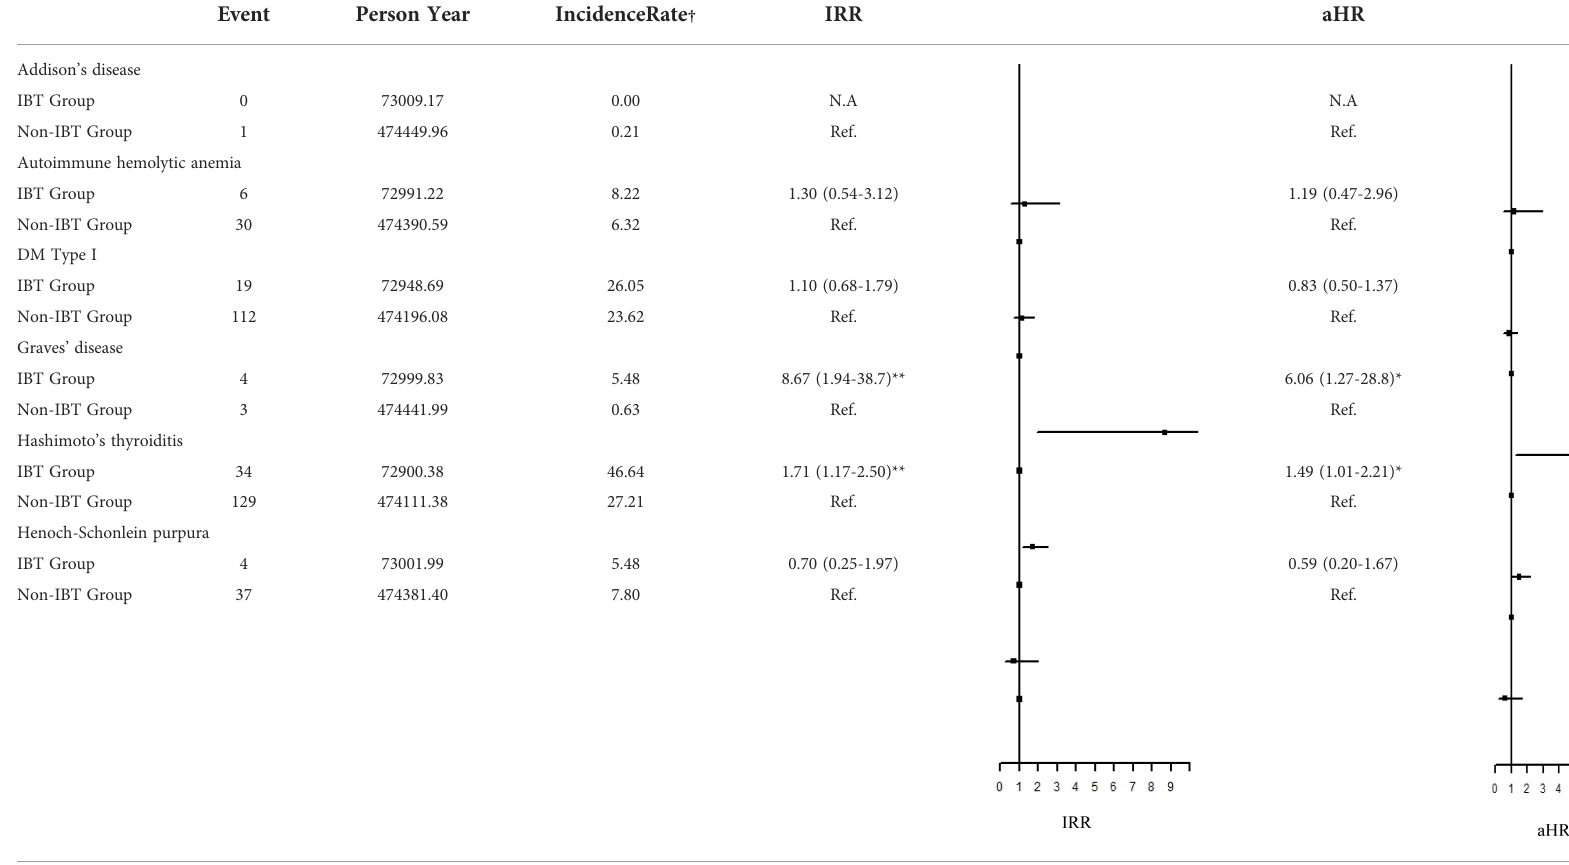
TABLE 3 Incidence Rate Ratio and Hazard Rate of the Risk of subgroup ADs between IBT and non-IBT